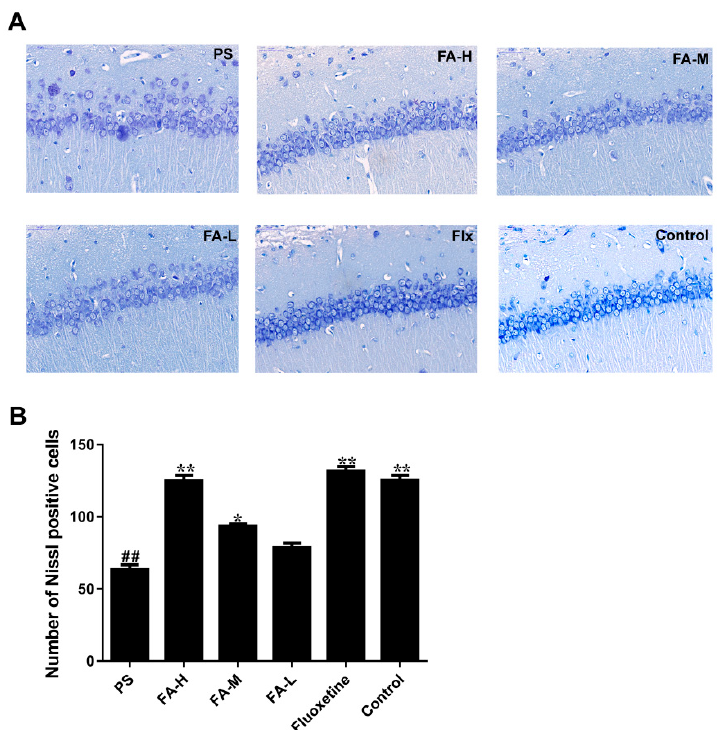
Figure 5. Effect of ferulic acid (FA) on hippocampus CA3 region neuron density in offspring rats exposed to prenatal stress. ( A ) Nissl staining of hippocampus CA3 region sections (magnification 400 × , Scale bar = 50 µ m), and ( B ) quantification of Nissl bodies in the hippocampus CA3 region. Data were expressed as mean ± SEM. n = 3 in each group, indicating at least three independent experiments in each animal. * p < 0.05 and ** p < 0.01 compared with PS group, ## p < 0.01 compared with Control group. FA-L: FA at low 12.5 mg/kg/day, FA-M: FA at medium 25 mg/kg/day, FA-H: FA at high 50 mg/kg/day; Flx: fluoxetine.